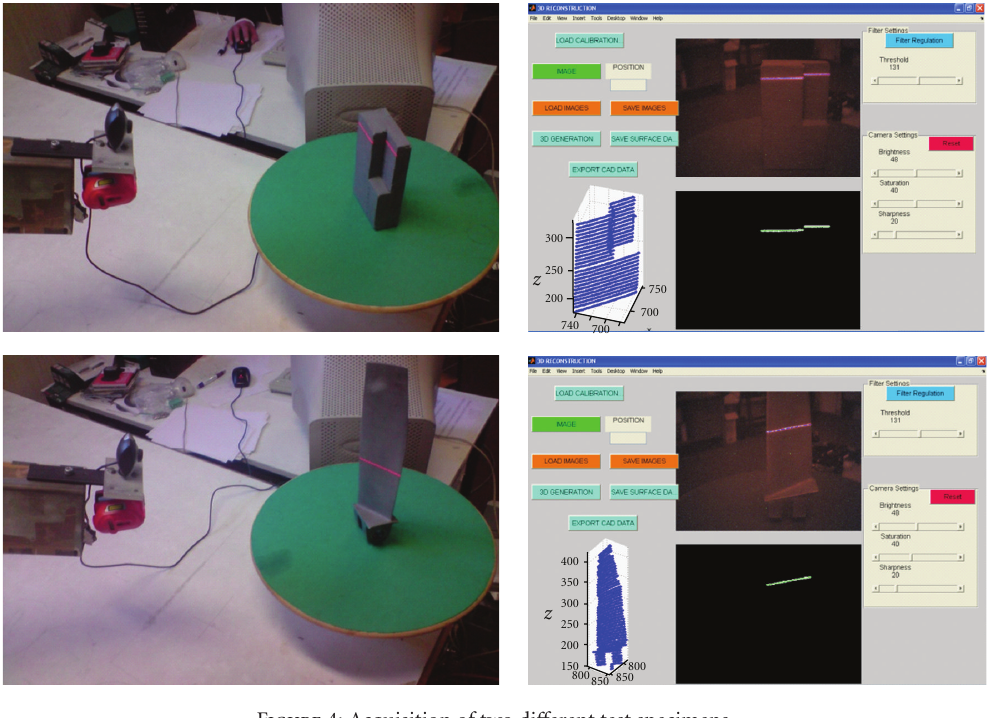
Figure 4: Acquisition of two di ff erent test specimens.